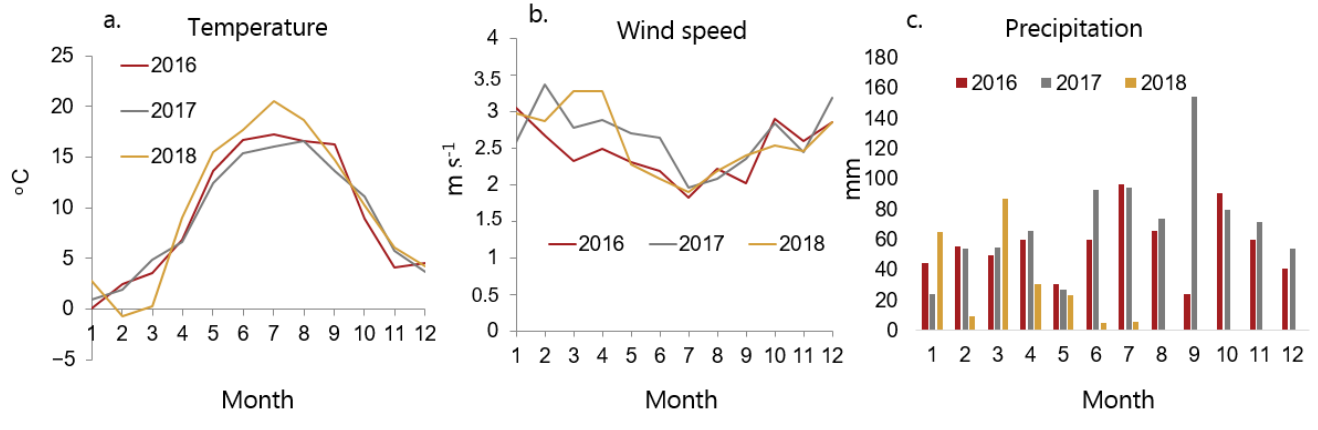
Figure 2. Weather data during the experiments: ( a ) daily average temperature, ( b ) wind speed, and ( c ) precipitation. Measurement height: 2, 2, and 1.5 m above ground level for temperature, wind speed, and precipitation, respectively.